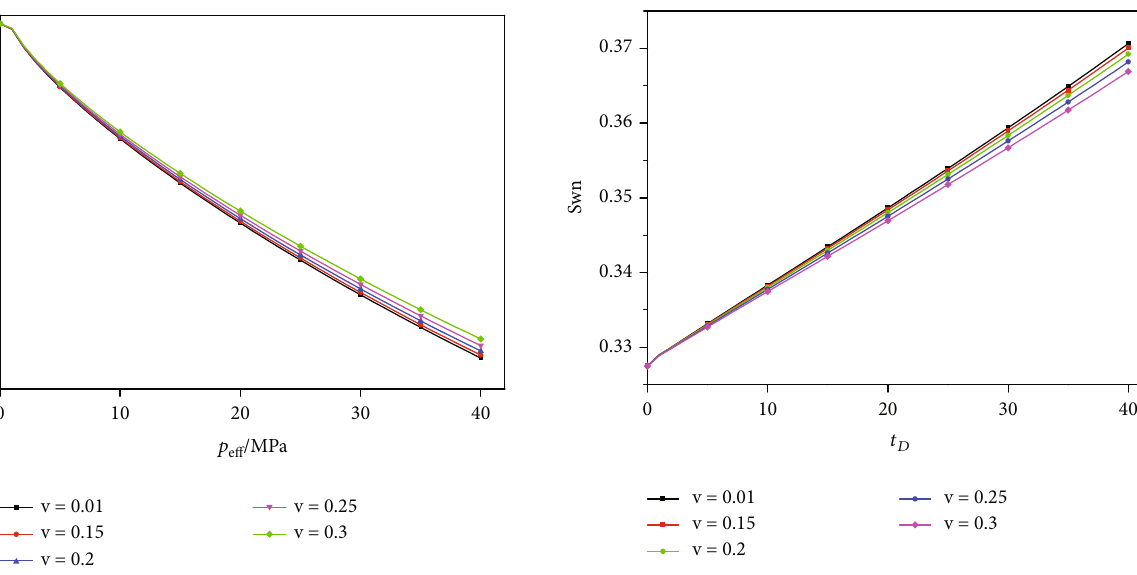
Figure 6: Relationship curve between permeability and e ff ective stress under di ff erent Poisson ’ s ratio.